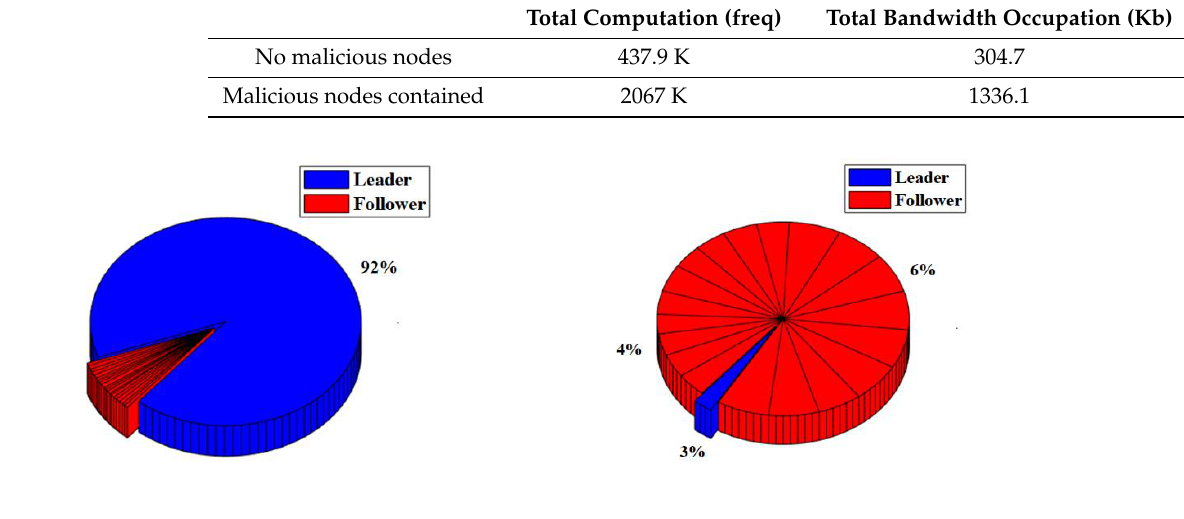
Figure 8. Resource occupation of the RAFT algorithm with no malicious nodes.